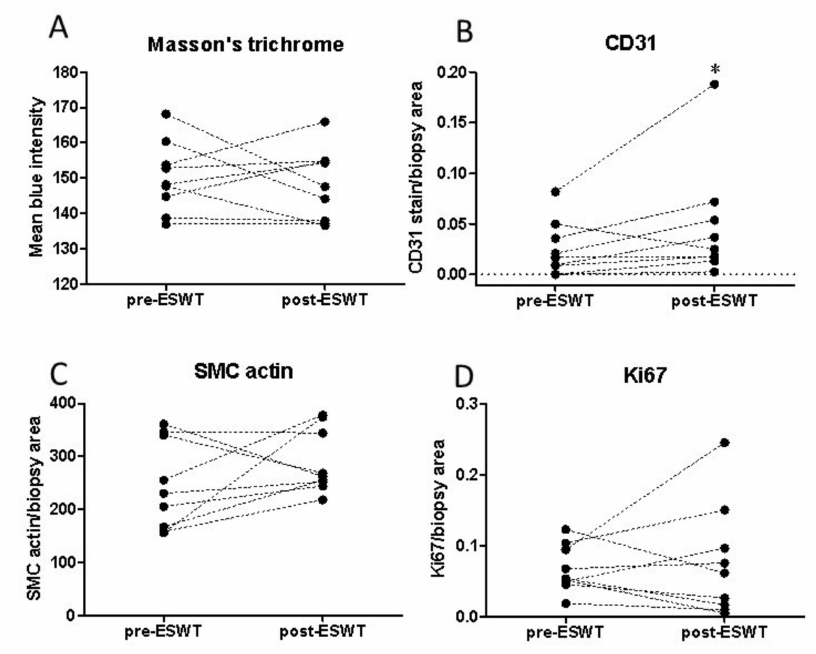
Figure 2. Extracorporeal shock wave therapy (ESWT) improves angiogenic markers in patient wound biopsies. ( A ) Collagen fiber deposition was quantified and presented as mean blue inten- sity of Masson‘s Trichrome stain in patient biopsies before and two weeks post-ESWT treatment. ( B ) Quantification of the CD31 stained area and ( C ) smooth muscle cell actin (SMC) stained area was determined as a marker of angiogenesis and ( D ) Ki67 staining per total wound biopsy area represented cell proliferation in individual patients pre- and post-treatment. Graphs represent values from individual patients; n = 9; * represents differences between the mean values before and after ESWT treatment, p <